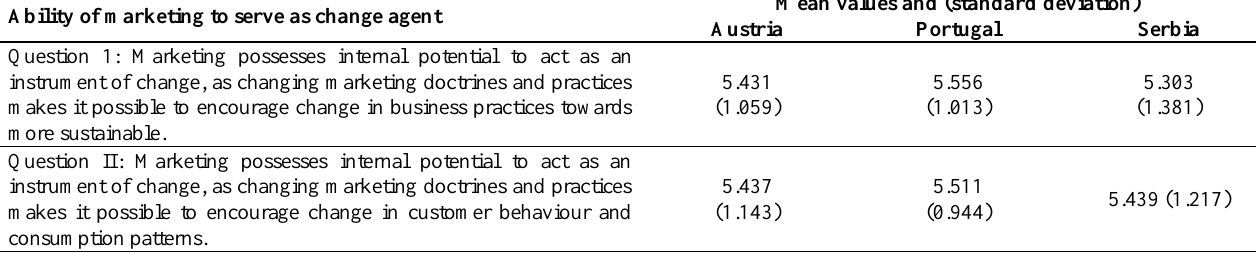
Mean values and (standard deviation)